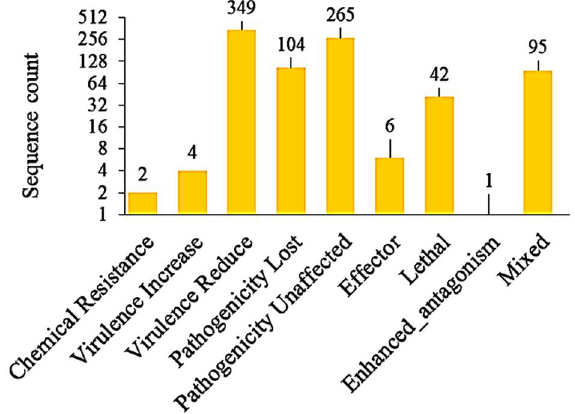
Figure 6. Identified pathogen–host interaction categories of M. grisea PMg_Dl-encoded protein sequences.